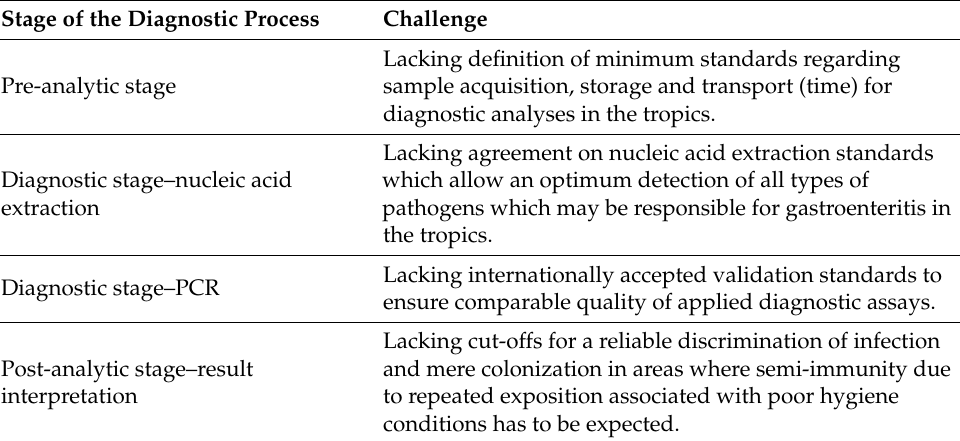
Table 1. Challenges for PCR targeting bacterial pathogens causing gastroenteritis with particular focus on the situation in the resource-limited